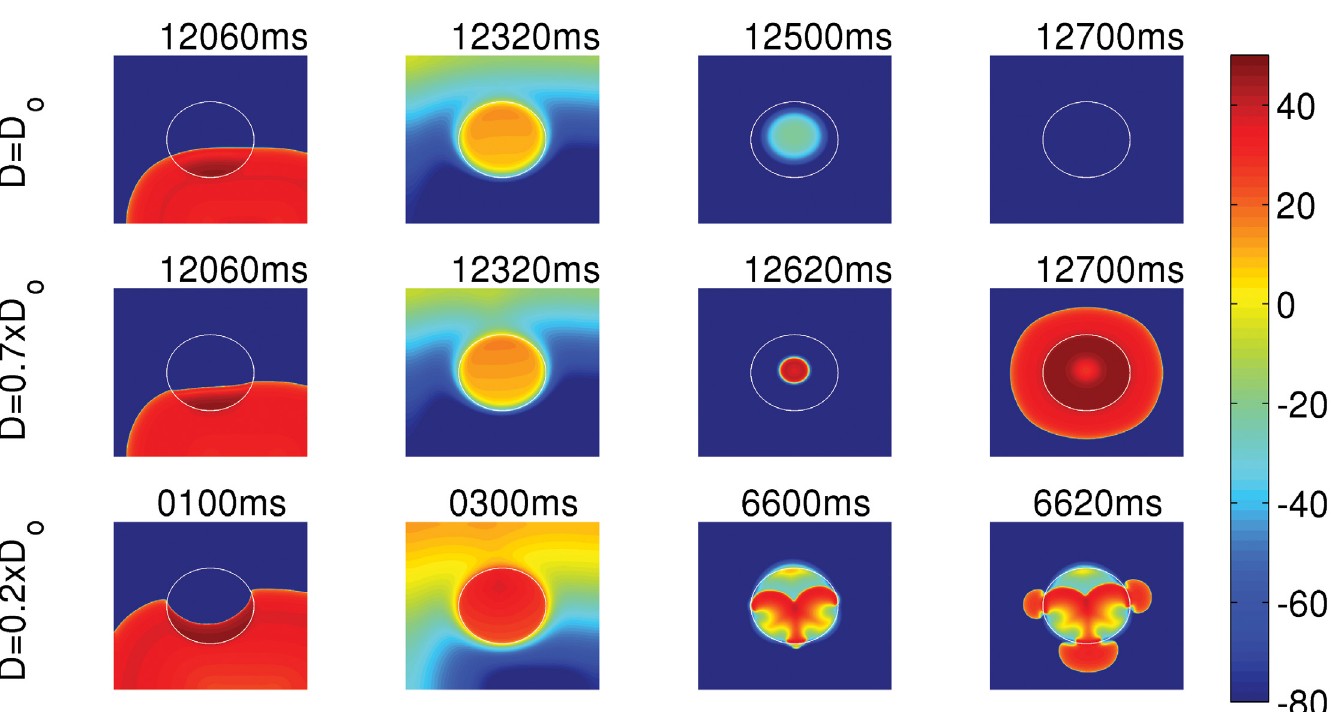
Fig 5. Dependence of the number N of PVC triggerings on the radius R, normalized coupling strength D/D o , and the percentage of fibrosis P f . The blue and red curves are for PCL = 1000 ms and 1400 ms, respectively. (A) Plots of N versus R, which show that the number of PVCs increases roughly with R. (B) Plots of N versus D/D o . The number of PVC triggerings increases initially with the reduction of D/D o , but saturates roughly when D/D o ≲ 0.4 and ≲ 0.65 for PCL = 1000 and 1400 ms, respectively. (C) Plots of N versus the percentage of fibrosis P f show a maximum at P f ’ 40%. A comparison of the plots in (A), (B), and (C) for the two different values of PCL, namely, PCL = 1000 ms and PCL = 1400 ms, shows that these plots depend sensitively on